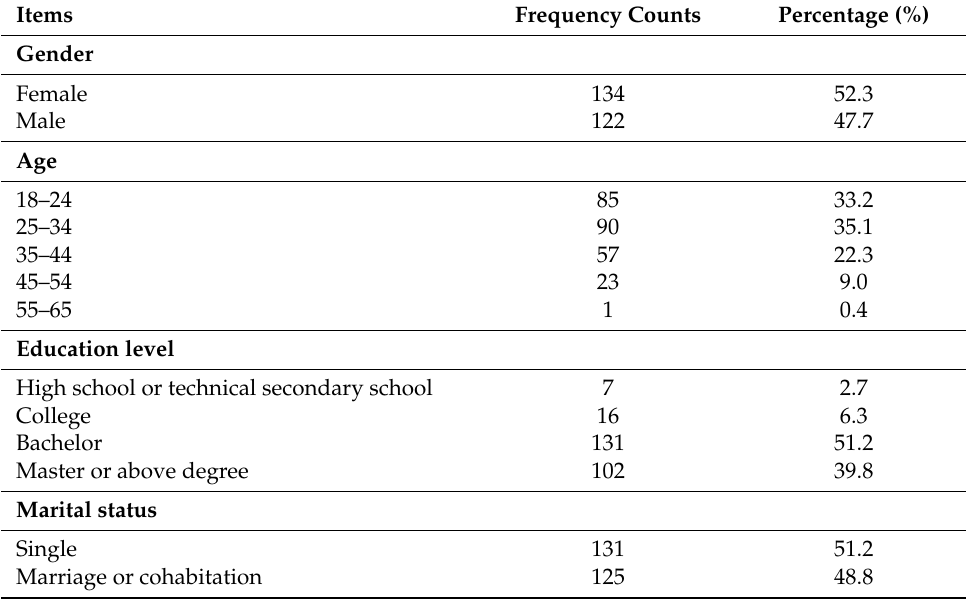
Table 1. The descriptive statistics of respondents’